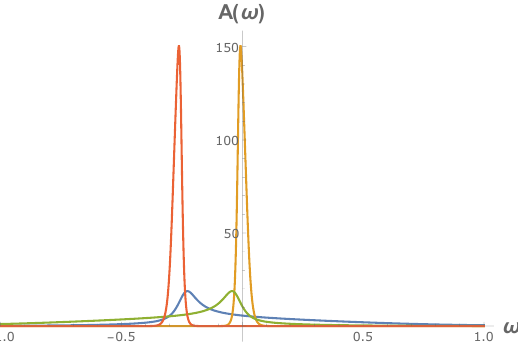
Figure 2. Plots of spectral function A ( ω ) in the two phases with chemical potential and with mass term. The blue curve is for the liquid state with chemical potential η = 0 . 27 . The yellow curve is for the dilute gas state with η = 0 . 27 . The green curve is for the liquid phase with mass µ = − 0 . 27 . The red curve is for the dilute gas phase with µ = − 0 . 27